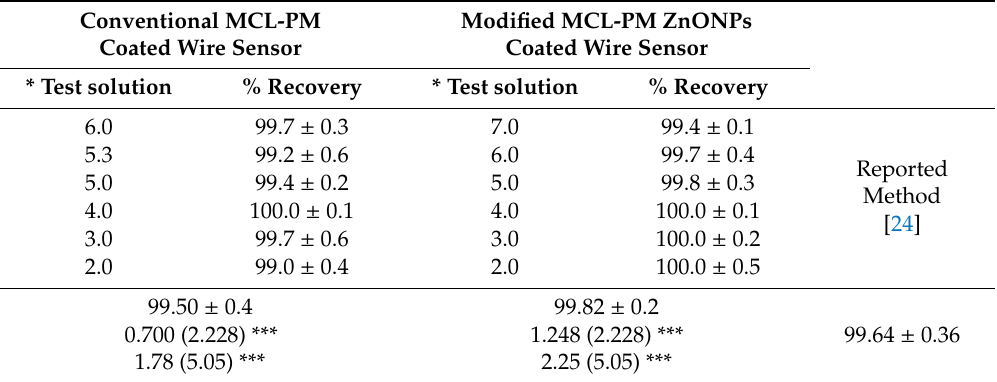
Table 5. Statistical analysis of data obtained from the determination of MCL in Minocycline hydrochloride ® tablets using conventional MCL-PM and modified MCL-PM-ZnONPs-coated wire